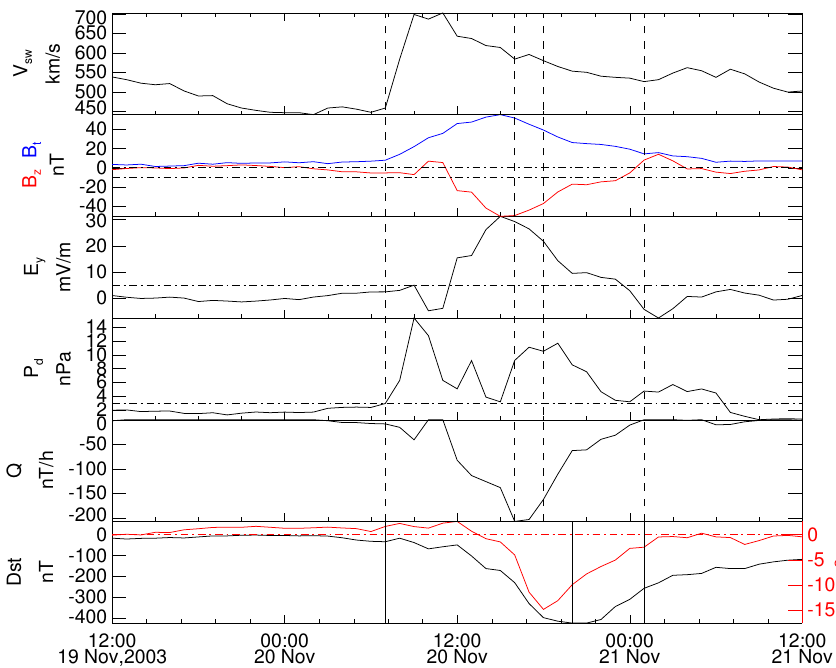
Figure 4. The great magnetic storm event on 20 November 2003. From top panel to bottom panel, there is the solar wind speed ( V sw ), the total strength of the IMF ( B t ) (blue line), and the north–south component B z (red line), the east–west electric field ( E y ), and the solar wind dynamic pressure ( P d ), the ring current injection term ( Q in which γ = 0.44), the global geomagnetic disturbance index J G p calculated by the SWM based on 8 stations (red line), and the Dst index (black line). The two horizontal line in panel 2 are B z = 0 nT and B z = − 10 nT, the horizontal line in panel 3 is E y = 5 mV/m, the horizontal line in panel 4 is P d = 3 nPa, and the horizontal line in the last panel is Dst = 0 nT and J G p = 0. The vertical lines in the top 5 panels are 07:00 20 Nov, 16:00 20 Nov, 18:00 20 Nov, and 01:00 21 Nov, respectively. The vertical lines in the bottom panel are 07:00 20 Nov, 20:00 20 Nov, and 01:00 21 Nov,